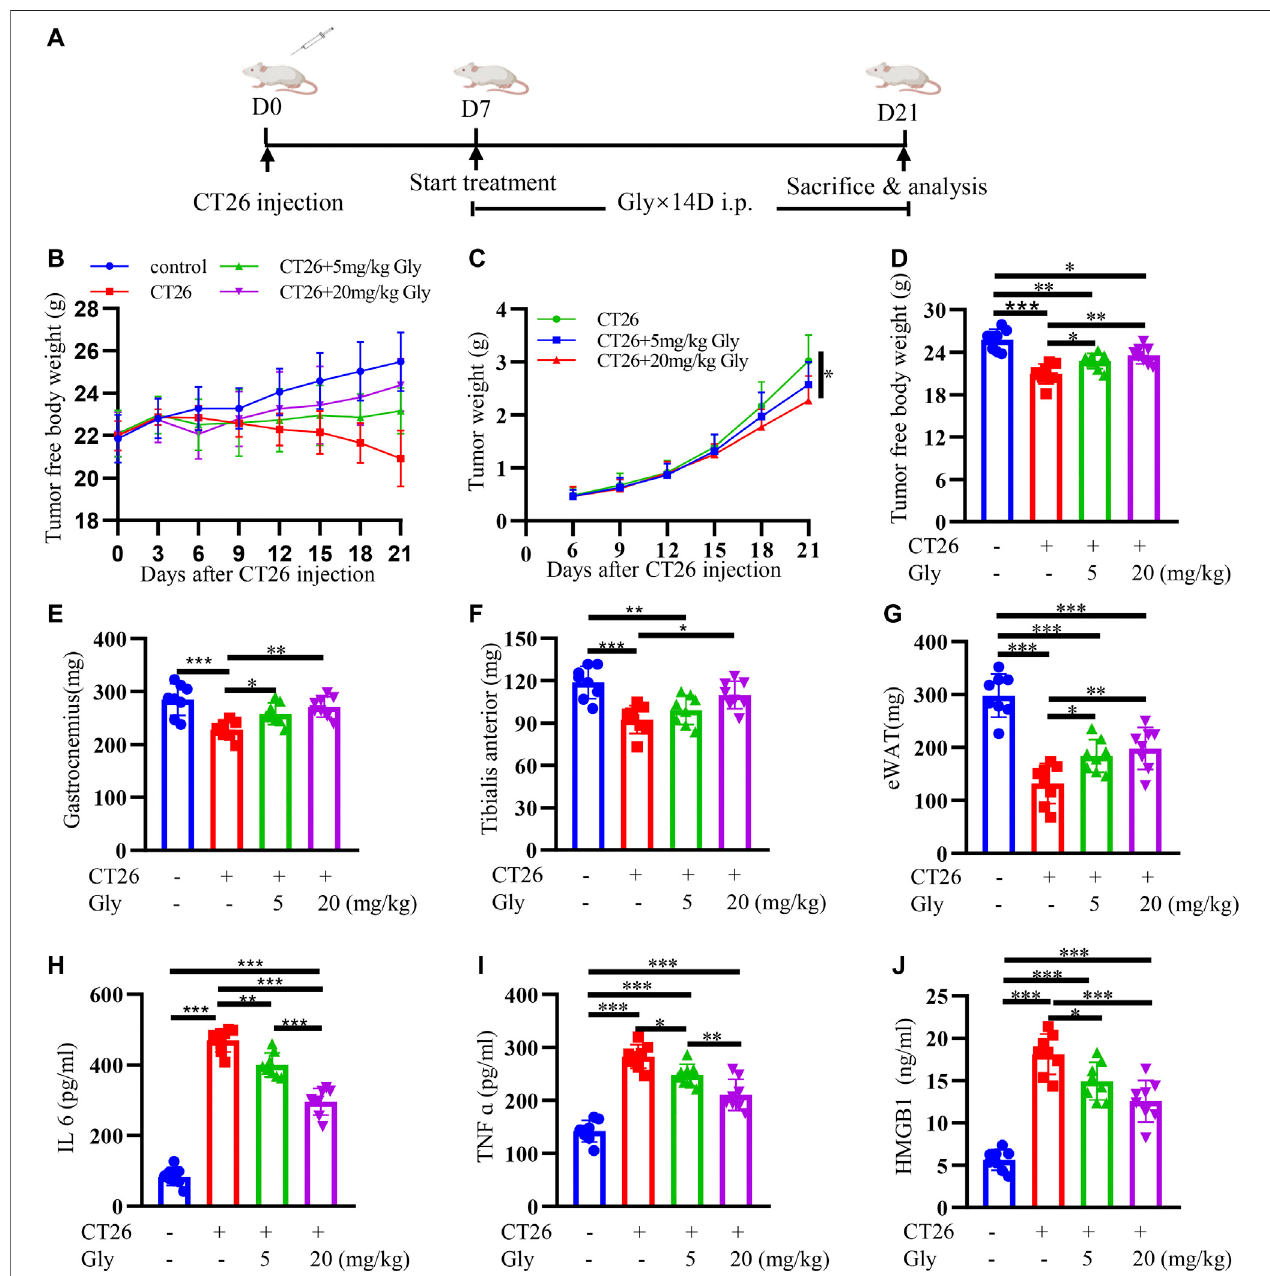
FIGURE7| HMGB1inhibitorglycyrrhizinalleviatescancercachexiainCT26tumor-bearingmice. (A) Schematicpresentationoftheanimalexperimentprotocol (B) Tumor-free body weight growth curve of BALB/c mice. (C) The tumor weight curve of BALB/c mice. The lean body weight (D) , bilateral gastrocnemius weight (E) , bilateral tibialis anterior weight (F) and bilateral epididymal weight (G) of BALB/c mice at 21 days of tumor implantation. The serum IL6 (H) , TNF α (I) , HMGB1 (J) in BALB/c mice.